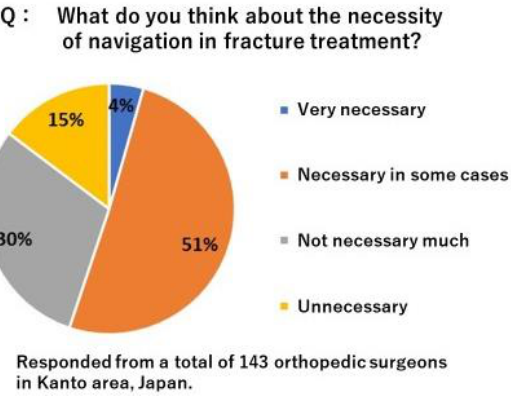
Figure 7. Results of the survey. The necessity of navigation in the fracture treatment.